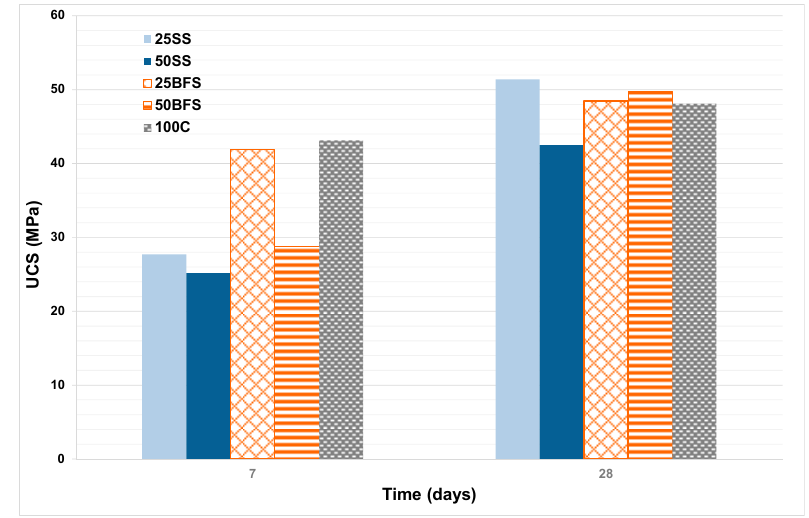
Figure 13. Evolution of the unconfined compressive strength (UCS) with time.